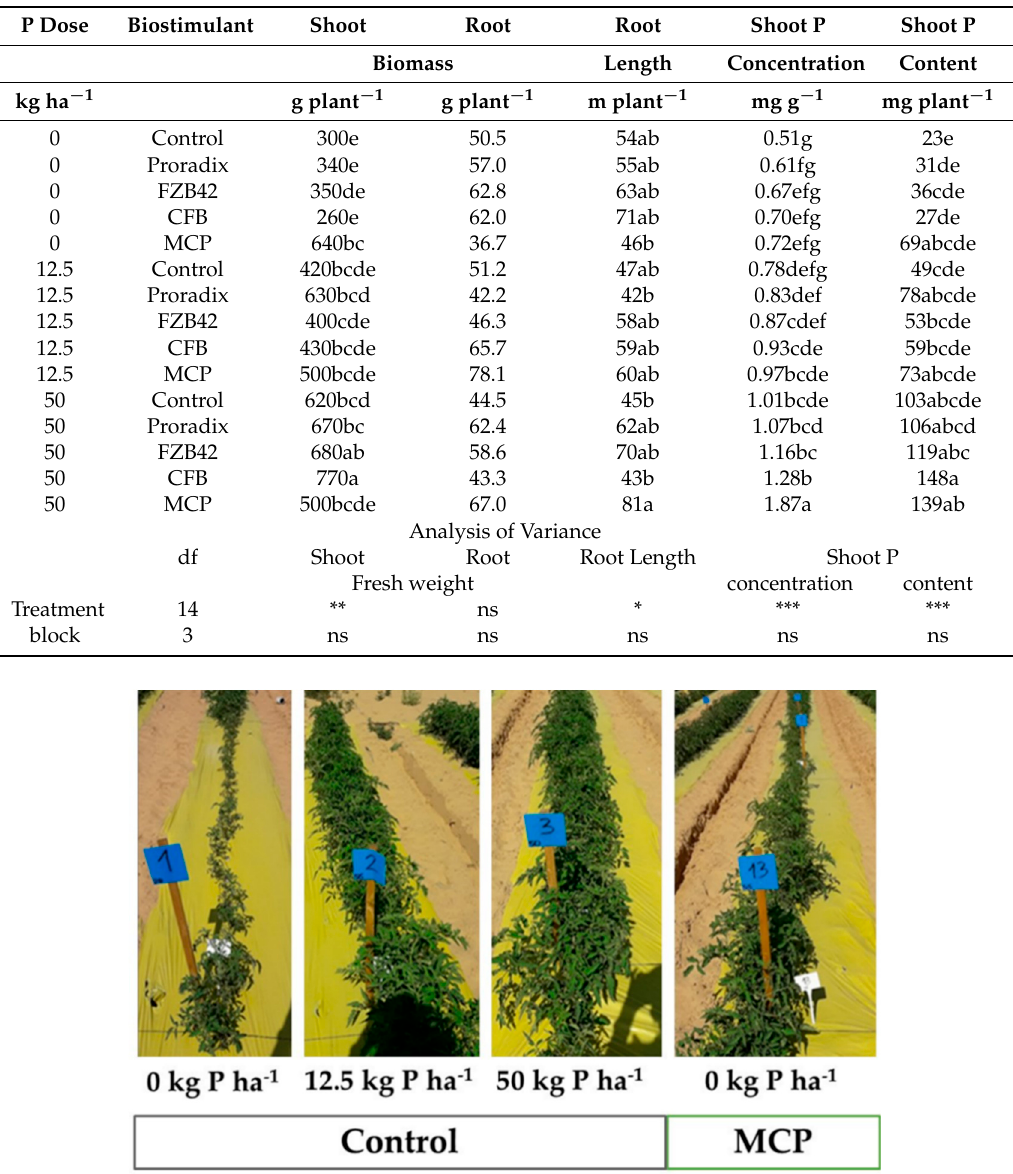
Table 1. Effect of banded P fertilization with DCD-stabilized ammonium sulfate and BS on the aboveground vegetative biomass production, root growth and shoot P status of tomato plants at 4 months after sowing, Ramat Negev, Israel. Data present means of four replicates. Statistical evaluation performed by two-way ANOVA. In each column, significant treatment differences (Tukey test, p ≤ 0.05, ** p < 0.01, *** p < 0.001, are indicated by different characters, n.s. = not significant, * = significant after Tukey–Kramer Honest Significant Difference (HSD) test).